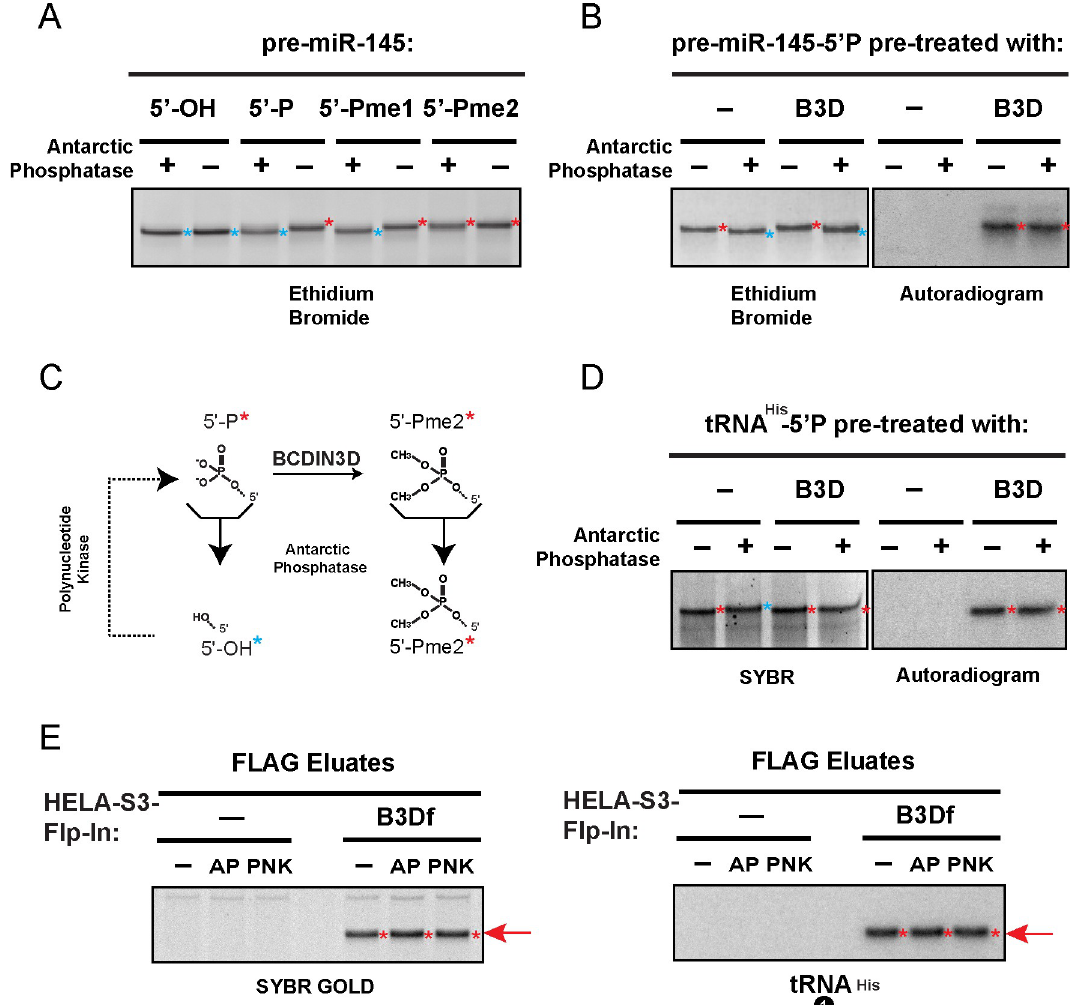
Fig 2. tRNA His interacting with BCDIN3D is phospho-methylated. A. Synthetic pre-miR-145 with either [5’-OH], [5’-P], [5’-Pme1] or [5’-Pme2] ends was treated with Antarctic Phosphatase. Please note that pre-miR-145-5’-OH (cyan � ) migrates faster than pre- miR-145 with [5’-P], [5’-Pme1] or [5’-Pme2] ends (red � ) on a denaturing 15% polyacrylamide/urea gel. B. Synthetic pre-miR-145 [5’- P] was in vitro methylated with BCDIN3D using radioactive [ 3 H]-SAM as methyl group donor prior to treatment with Antarctic Phosphatase. The left panel shows the ethidium bromide stained gel that was used for the autoradiography in the right panel, which shows only the in vitro methylated RNAs. Please note that only a small fraction of 5’P pre-miR-145 is dimethylated by BCDIN3D in vitro, explaining why AP treatment induces a gel shift in the left panel, which shows the total pre-miR-145, but not in right panel, which shows only the methylated pre-miR-145. C. Schematic showing the 5’ ends and the effect of Antarctic Phosphatase (AP) and Polynucleotide Kinase (PNK). D. Synthetic tRNA His -5’-P was in vitro methylated with BCDIN3D using radioactive [ 3 H]-SAM as methyl group donor prior to treatment with Antarctic Phosphatase. The left panel shows the ethidium bromide stained gel that was used for the autoradiography in the right panel. Please note that tRNA His -5’-OH (cyan � ) migrates slower than tRNA His with [5’-P], [5’-Pme1] or [5’-Pme2] (red � ) ends. E. RNAs purified from HeLa-S3-Flp-In and HeLa-S3-Flp-In-BCDIN3Df FLAG eluates were treated with mock, AP or PNK, and separated on a denaturing 15% polyacrylamide/urea gel and probed with the tRNA His northern blot probe #1. Neither the treatment with AP nor T4 PNK shifted the migration of tRNA His (Fig 1C). The treatment with PNK is a control to verify that the 5’ end is not 5’OH in BCDIN3Df-interacting tRNA His . major reasons: 1) the annotated hsa-miR-4454 does not have an optimal miRNA stem-loop as defined by [19] (S4 Fig); 2) the annotated hsa-miR-4454 genomic locus does not display any feature of transcriptionally active chromatin in HeLa-S3-FlpIn cells (S4B Fig); and 3) the anno- tated hsa-miR-4454 sequence is the reverse complement of the primer binding site of a